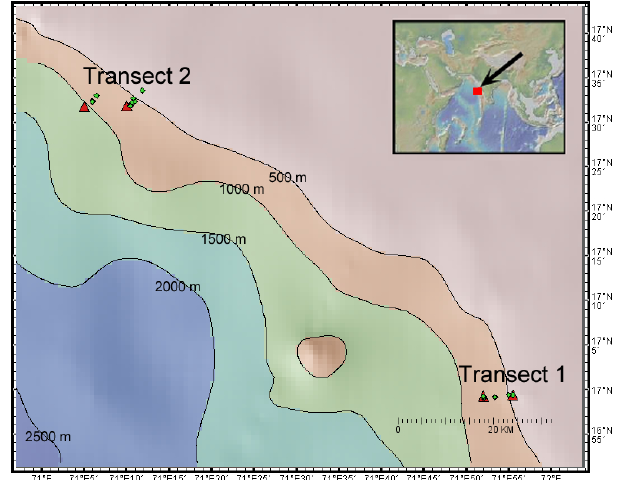
Fig. 1. Location of transects 1 and 2 with colonization trays (red tri- angles) and ambient cores (green circles) on the W. Indian margin.